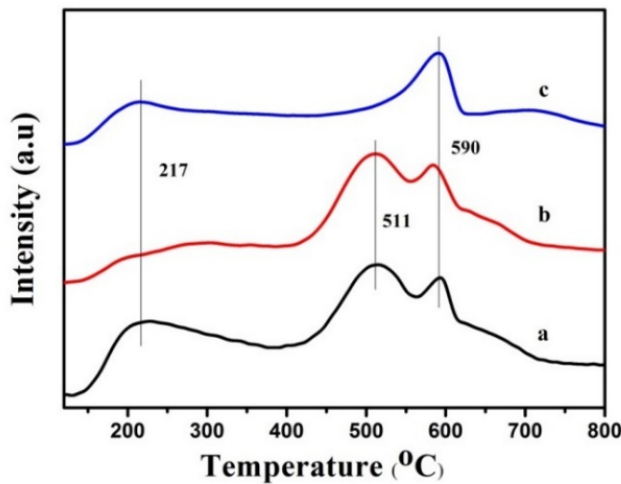
Figure 10. Temperature ‐ programmed desorption of NH 3 (NH 3 ‐ TPD) profiles of PtSn/Mg(Al)O with different Mg:Al ratios: ( a ) Mg:Al = 2:1; ( b ) Mg:Al = 5:1; ( c ) Mg:Al = 10:1.